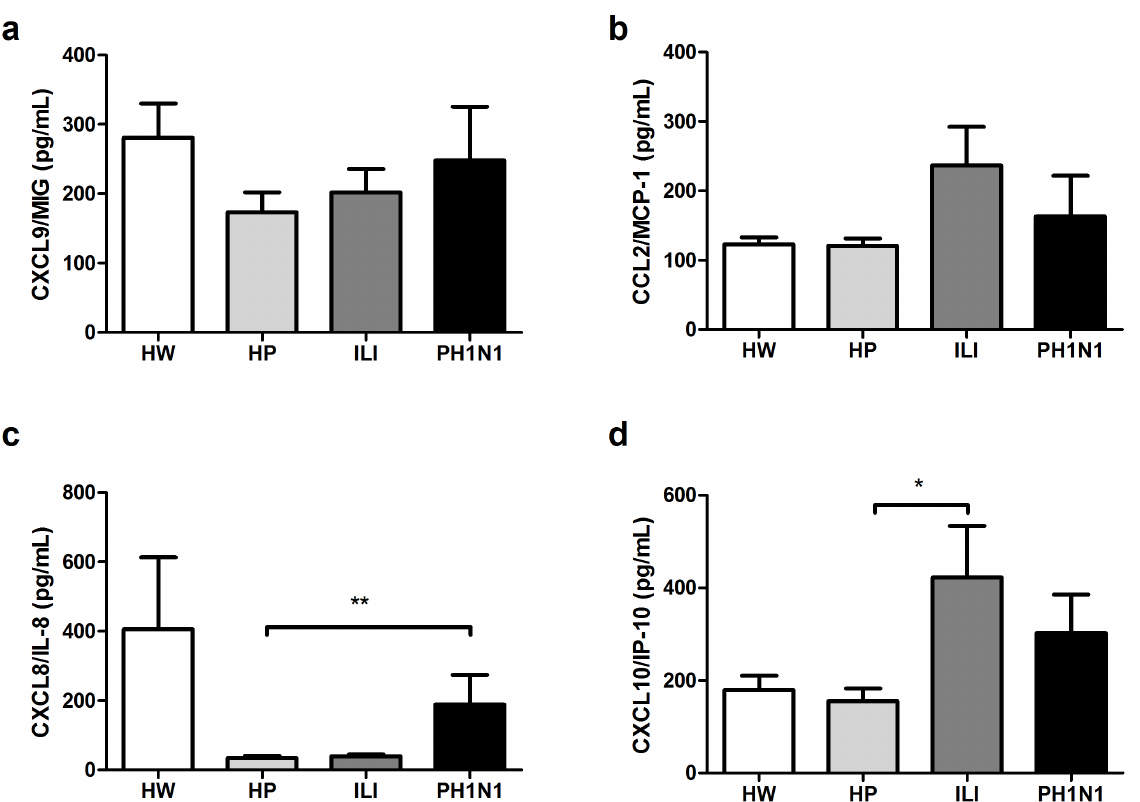
Figure 3. Serum chemokine concentrations in HW, HP, ILI and PH1N1 women. The chemokine CXCL9/MIG (a), CCL2/MCP-1 (b), CXCL8/IL-8 (c) and CXCL10/IP-10 (d) concentrations were quantified using a CBA system with flow cytometry. The Kruskal-Wallis test with Dunn’s multiple comparison post-test was performed using the GraphPad Software. The significance values were *p , 0.05, **p , 0.01, ***p , 0.001.